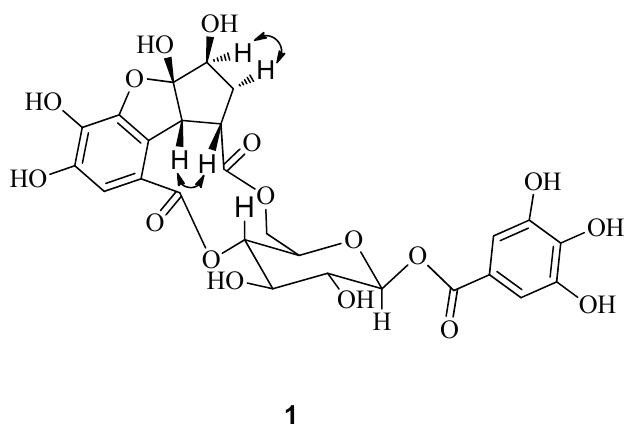
Figure 3. Selected NOESY correlations ( ) of compound 1 .